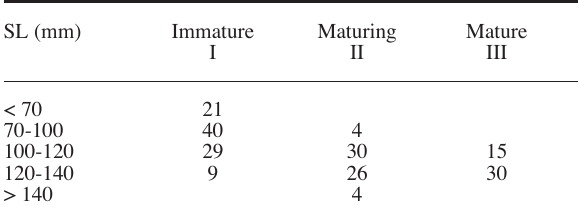
T ABLE 7. – Age-length key of Bathypterois mediterraneus caught in the Western Ionian and in the Eastern Ionian Sea. N, number of individuals; SL, standard length; S.D., standard